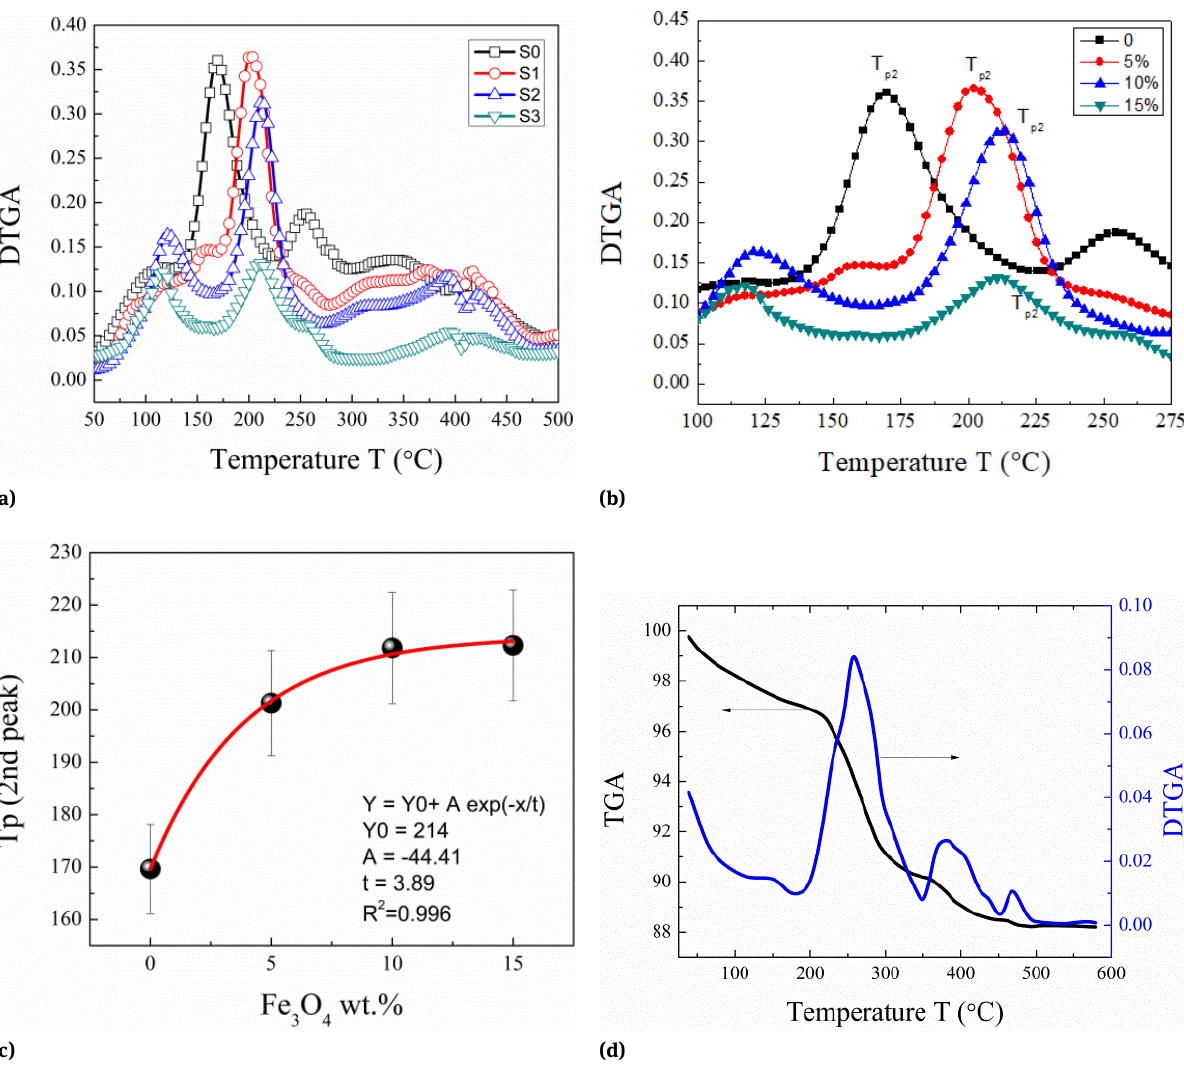
Figure 10: a) and b) DTGA curves for PVA/PANi blend and samples loaded with Fe 3 O 4 , c) Dependence of the second reaction peak position (T p 2 ) on the filler weight ratio, d) TGA and DTGA curves for Fe 3 O 4